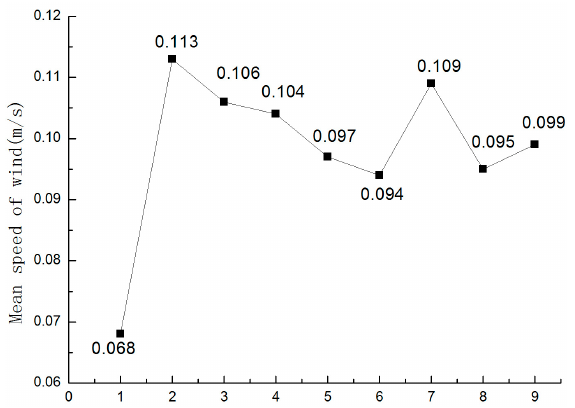
Figure 10. Comparison of wind speed in nine tests.